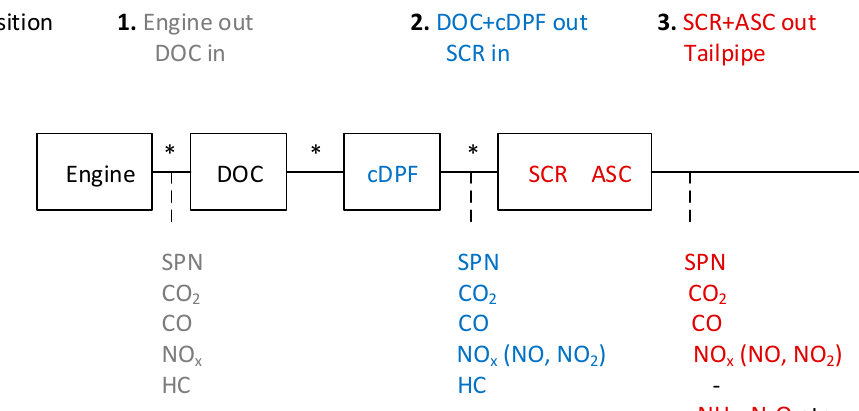
Figure 9. Experimental setup. Sampling positions and the naming conventions. Asterisks indicate exhaust gas temperature measurements. ASC = ammonia slip catalyst; cDPF = catalyzed Diesel particulate filter; DOC = Diesel oxidation catalyst; SCR = selective catalytic reduction; SPN = solid particle number.